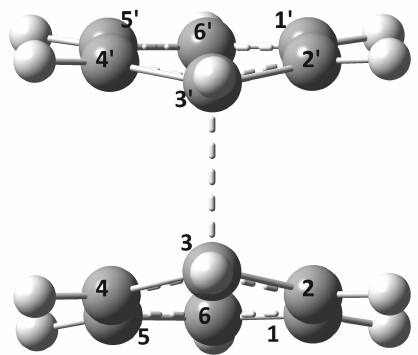
Figure 4. The transition state (TS D (I)) configuration between the R e (S 1 ) and CI D (II) geometries computed at the NEB-TS- ω B97X-D3/ma-def2-TZVPP level of